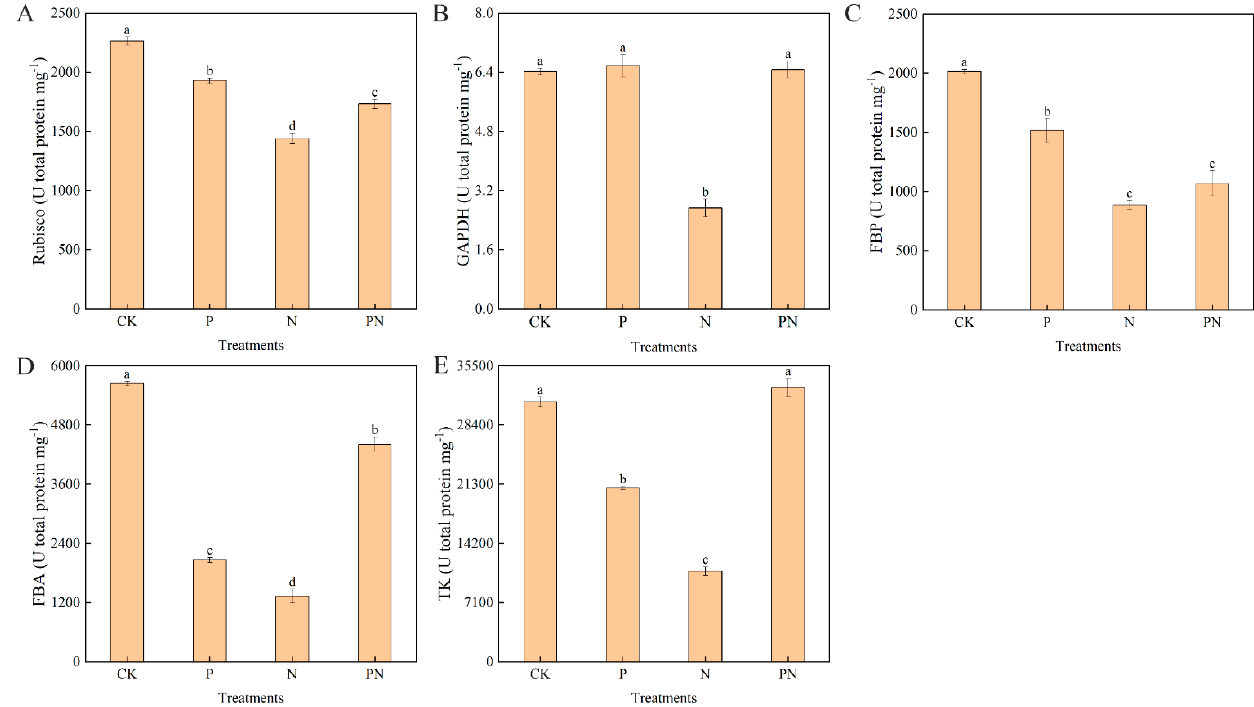
Figure 3. Effect of exogenous proline on the activity of key Calvin cycle enzymes in celery leaves under salt stress. After planting the 35-day-old seedlings for 7 days, they were treated with 0.3 mM proline solution for 7 days, after which they were watered with 100 mM NaCl solution thrice every 3 days. ( A ) 1,5-diphosphate carboxylase, Rubisco. ( B ) 3-Glyceraldehyde-phosphate dehydrogenase, GAPDH. ( C ) Fructose-1,6-bisphosphatase, FBPase. ( D ) Fructose 1,6-diphosphate aldolase, FBA. ( E ) Transketolase, TK. The results are expressed as the mean ± SE of three replicates, and the different letters denote the significant difference among treatments ( p < 0.05), according to Duncan’s multiple tests. CK, control. P, 0.3 mM proline. N, 100 mM NaCl. PN, 100 mM NaCl+ 0.3 mM proline.